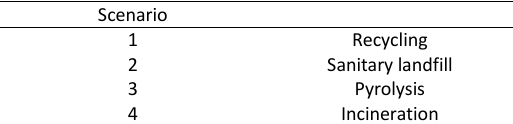
Table 8: Waste management scenarios in Brujen industrial park